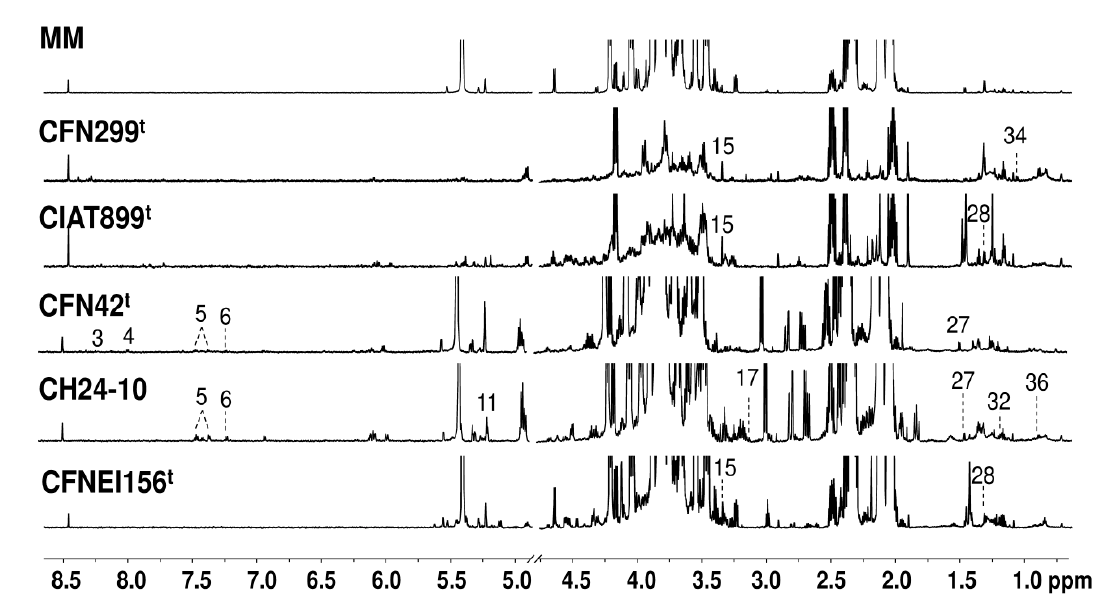
Figure 2. Representative 1 H NMR spectra (700 MHz, 298K, TSP = 1 mM, D 2 O sodium phosphate buffer 0.123M at pH 7.4) of MM and rhizobial strains culture supernatant at stationary phase (50 h), the compounds that were only detected at this sampling time in